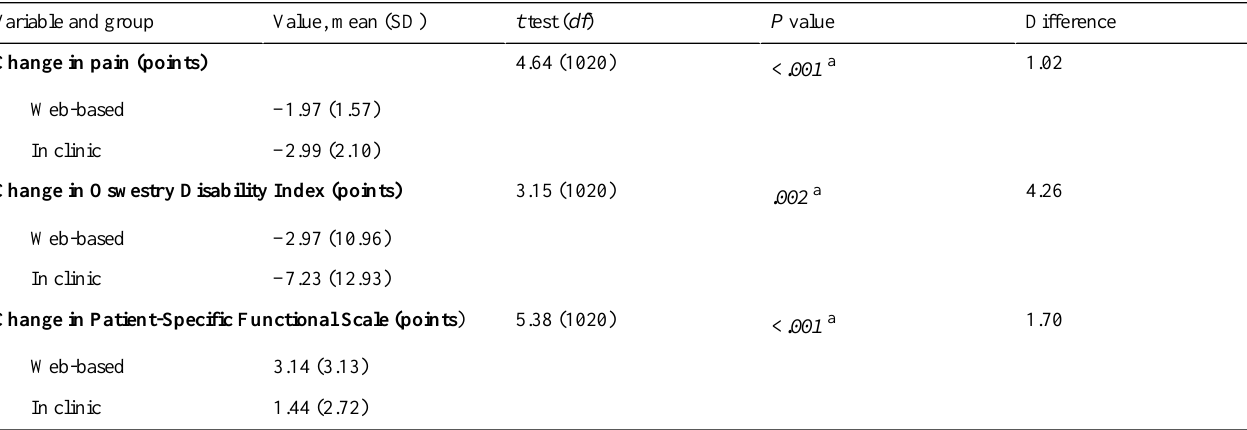
Table 2. Unadjusted comparisons for primary outcomes of interest between online integrated practice unit and in-clinic integrated practice unit groups.